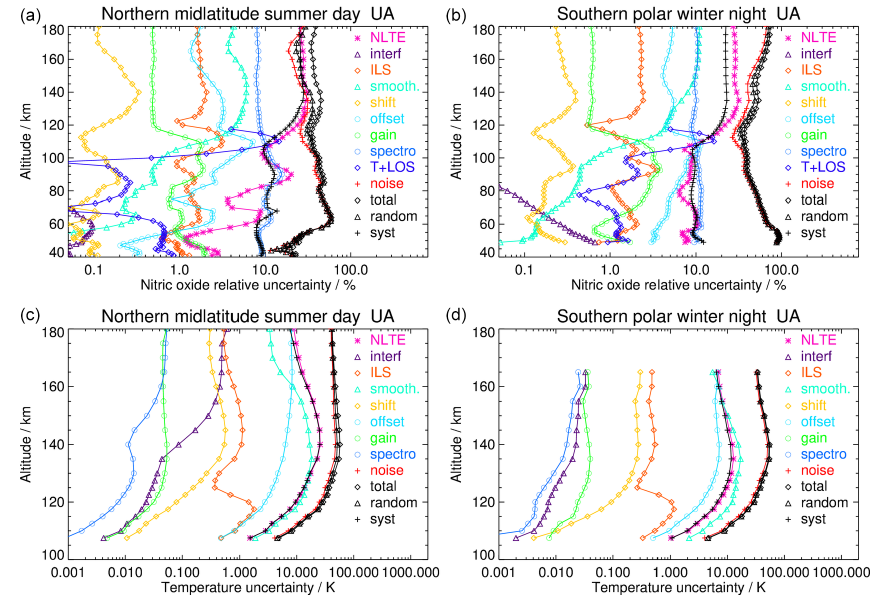
Figure 6. As Fig. 5 but for (a, b) NO and (c, d) temperature from UA observations.